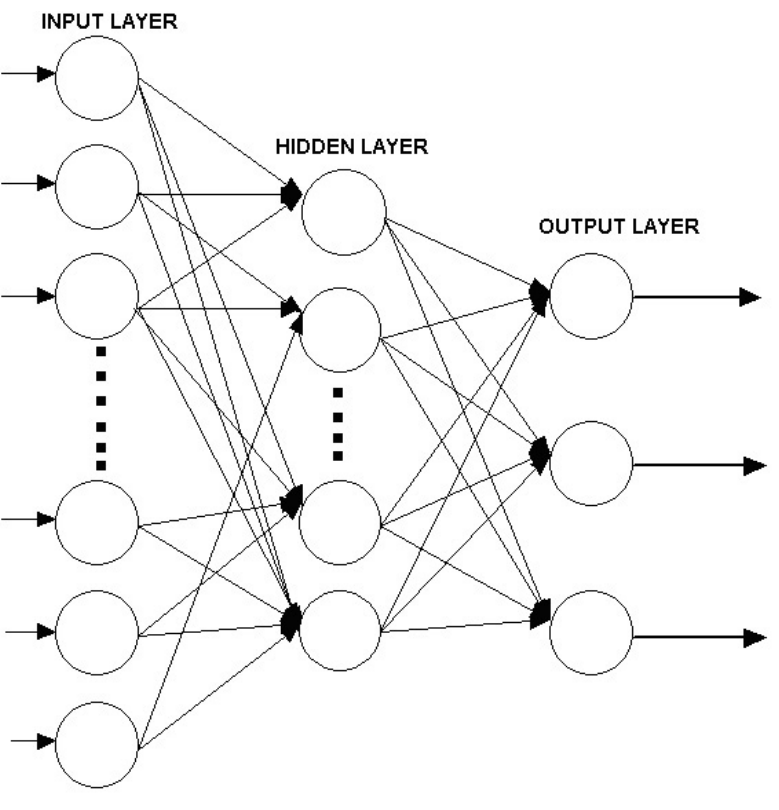
FIGURE 2. Illustration of a three-layered neural network with one input layer, one hidden layer, and one output